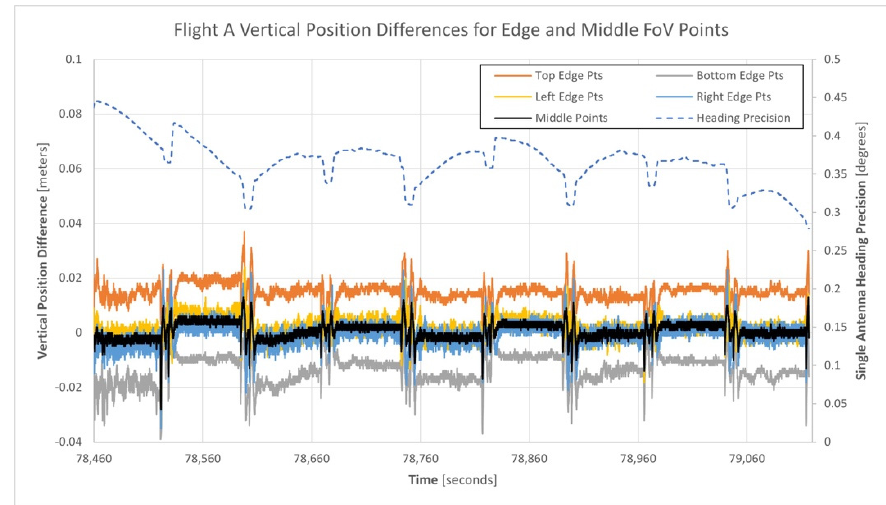
Figure 16. Vertical position differences between the single and dual-antenna generated point clouds for the five regions of points of flight A.